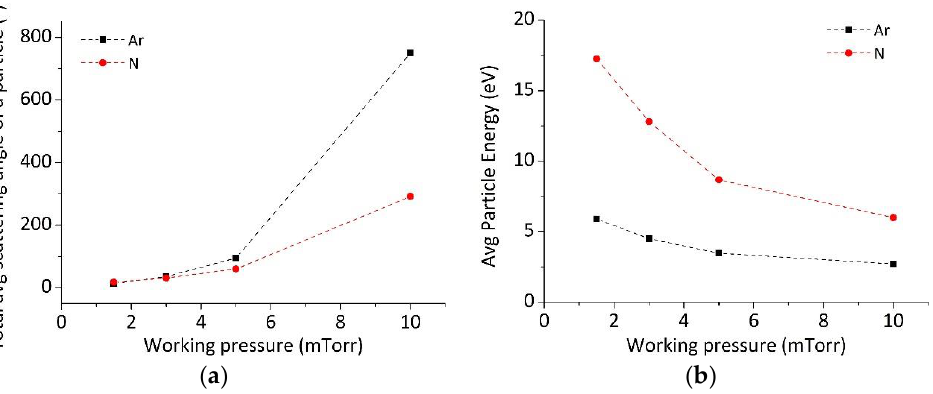
Figure 12. Summary of ( a ) mean average total scattering angle and ( b ) mean average particle energy of simulated particles reaching the substrate after being sputtered using Ar (black) and N (red) at different working pressures in GLAD configuration. A range of total average scattering angle of the particles was simulated at different pressures and the mean of this averaged range was used to summarize the results in ( a ). Similarly, a range of average 𝐸 P was simulated at different pressures and the mean of this averaged range was used to summarize results in ( b ).